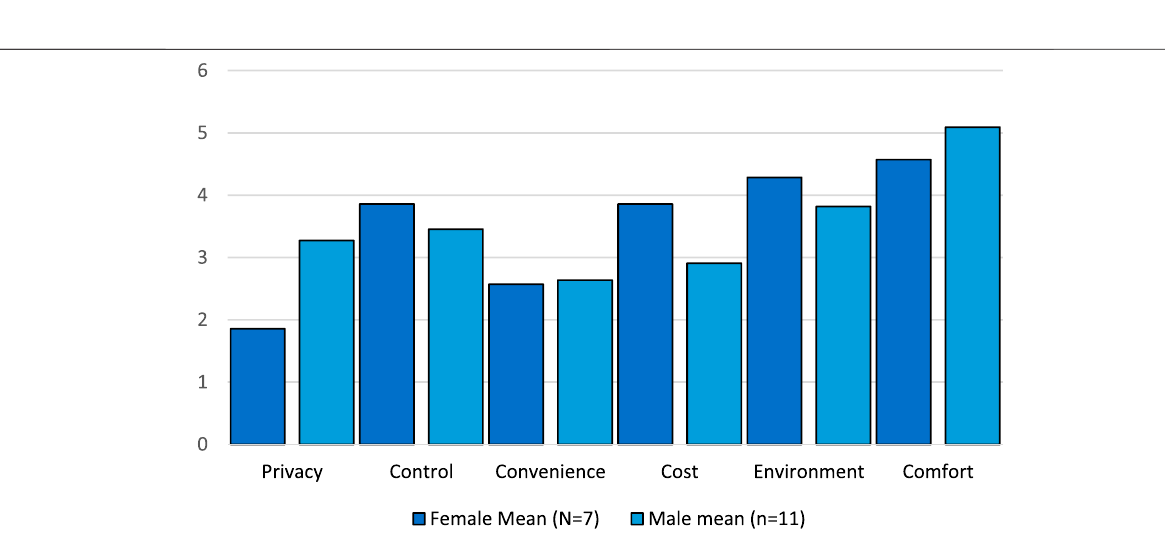
Frontiers in Energy Research |